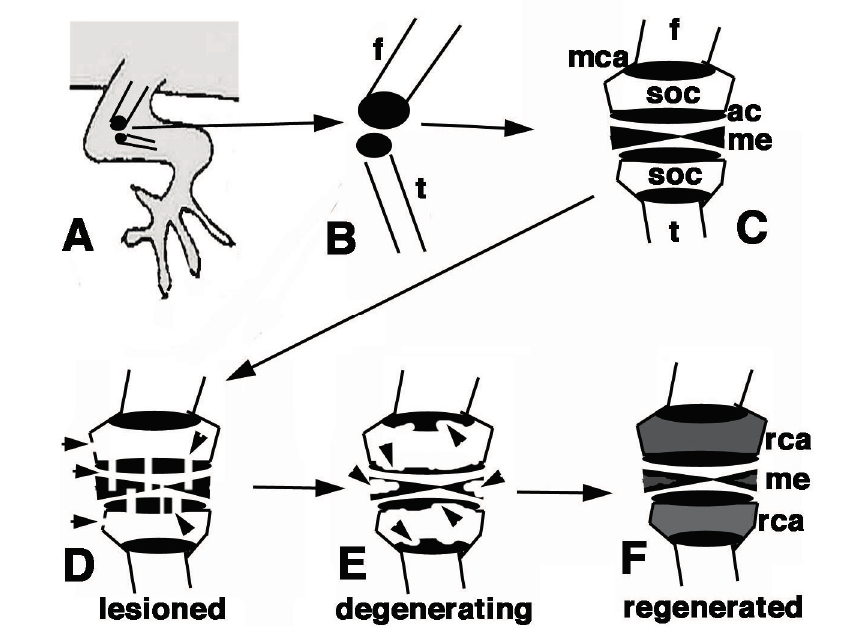
Figure 10. Schematic summary of the present results. ( A ) Hind limb with indicated operated area of the knee; ( B ) Detail of the epiphysis (in black) of the femur and tibia; ( C ) Detailed view of the regions of the femur and tibia epiphyses present in a normal knee; ( D ) The damaged areas are schematically indicated by the arrowheads on the epiphyses and meniscus/ligaments; ( E ) The following degeneration of the cartilaginous tissue is indicated by arrowheads; ( F ) The regenerated cartilage in (in grey) after 3 weeks in our experimental conditions fills up most of the space initially occupied by the secondary ossification centers. Also the cartilaginous part of the meniscus is likely regenerated. Legends : ac, articular cartilage; f, femur; me, meniscus; mca, metaphyseal cartilaginous (growth) plate;rca, regenerated cartilage; soc, secondary ossification center; t,